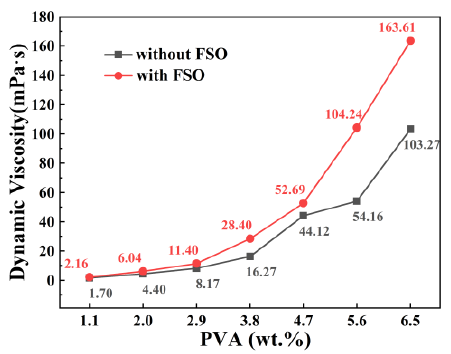
Figure 1. Precursor solutions dynamic viscosity.